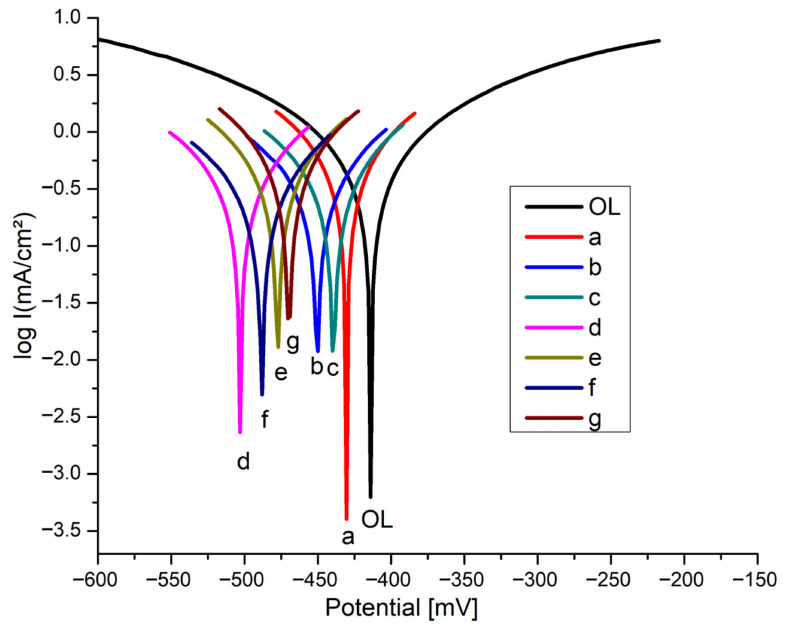
Figure 5. Tafel polarization curves registered in 0.1 M HCl media for the studied thin films: